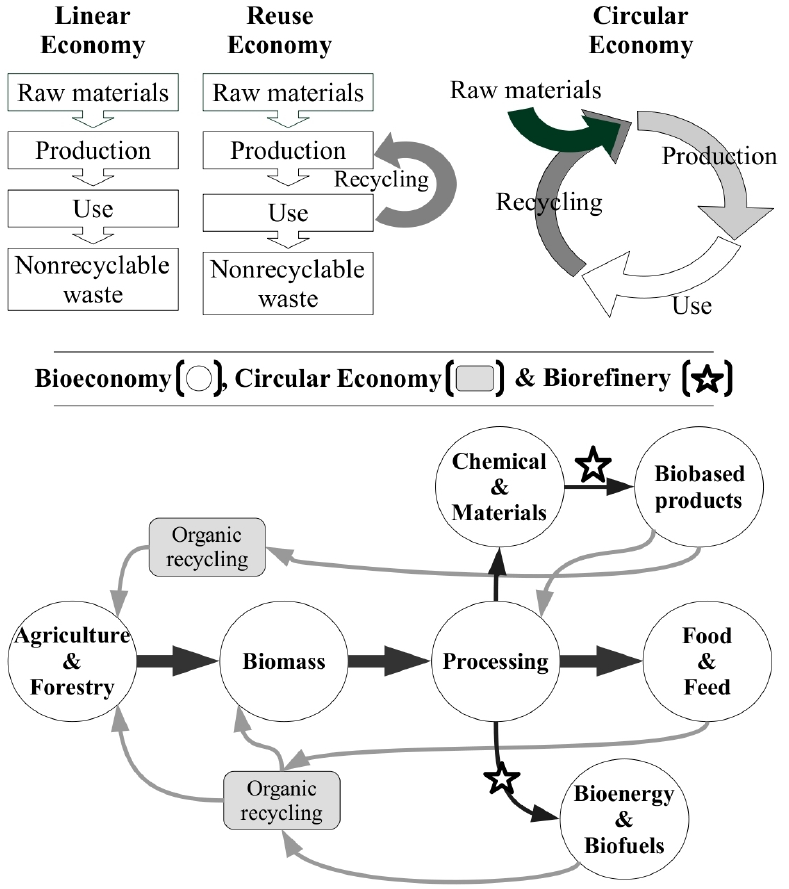
Figure 1. Flux diagrams of a linear economy, reuse economy, circular economy, bioeconomy, and the potential niches for